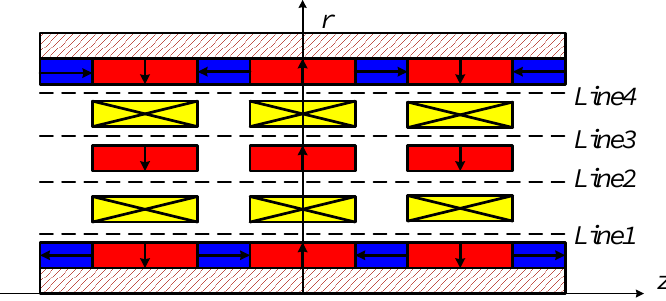
Figure 10. Positions for comparison of numerical result and analytical models.